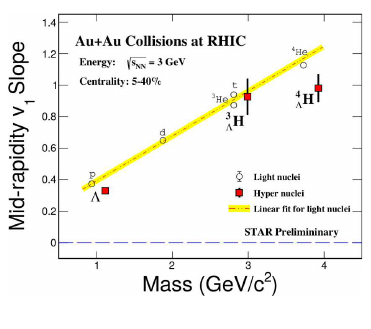
Figure 4. Mass dependence of the mid-rapidity v 1 slope d v 1 / d y for Λ , 3 H and 4 H, from the √ s NN = 3 GeV Λ Λ | y = 0 mid-central 5-40% Au + Au collisions. Combined results of 2-body and 3-body decays are used for 3 H while the 4 H is Λ Λ only reconstructed from the 2-body decay. The slopes of light-nuclei p, d, t, 3 He and 4 He from the same collisions are shown as open circles. The yellow-red line is the result of a linear fit to the measured light nuclei v 1